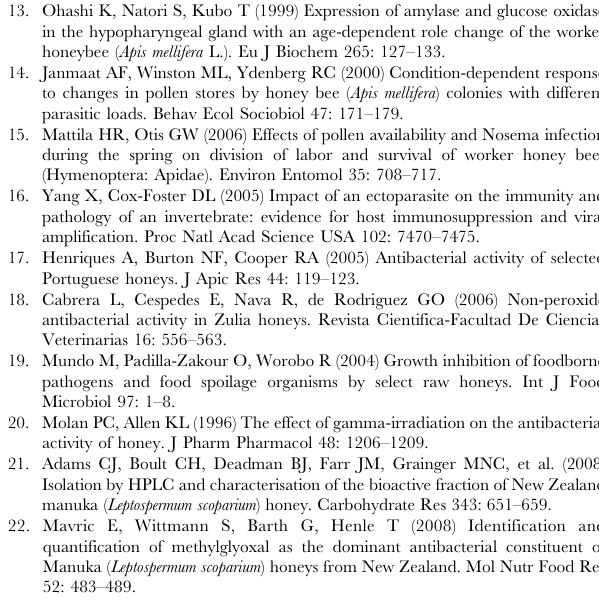
Supporting Table S1 Complete list of honey samples included